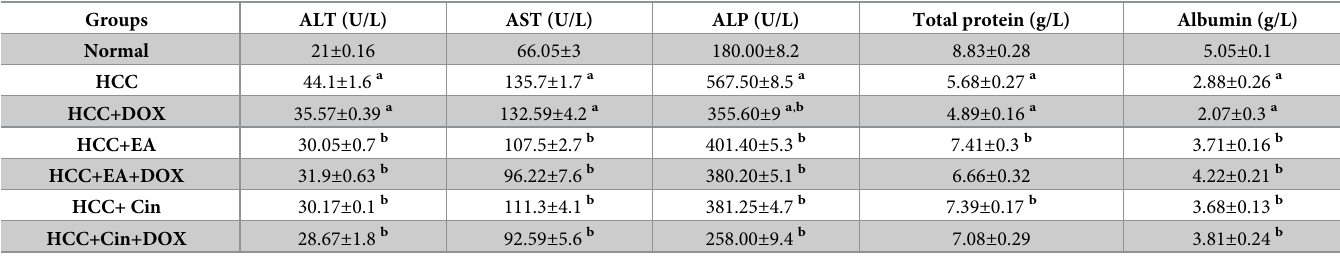
Table 1. Effect of 1,8 cineole (Cin), ellagic acid (EA), doxorubicin (DOX) and combinations on serum liver markers of DEN/2-AAF-administered rats. Groups